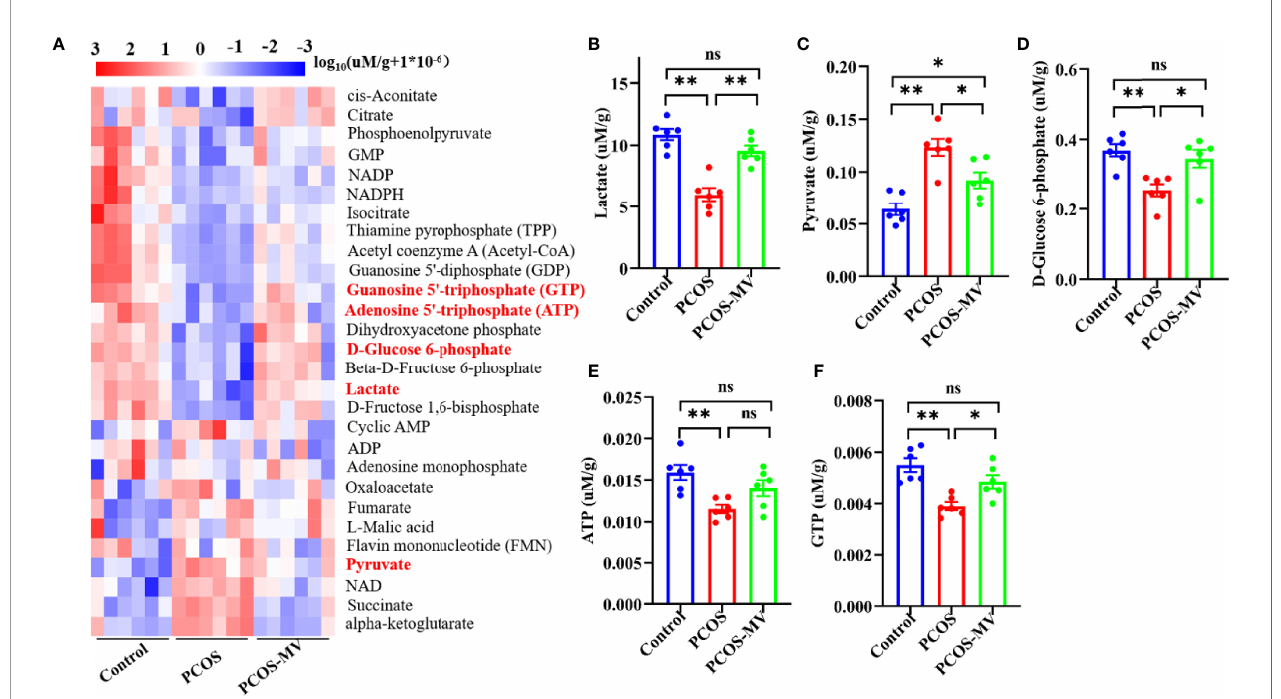
FIGURE 3 | Targeted energy metabolomics analysis of ovarian tissues. (A) Cluster analysis of energy metabolites among control, PCOS and PCOS-MV groups (n = 6 rats per group). (B) Lactate. (C) Pyruvate. (D) D-Glucose 6-phosphate. (E) ATP. (F) GTP. Signi fi cant differences between groups were respectively indicated as* P < 0.05 and ** P <